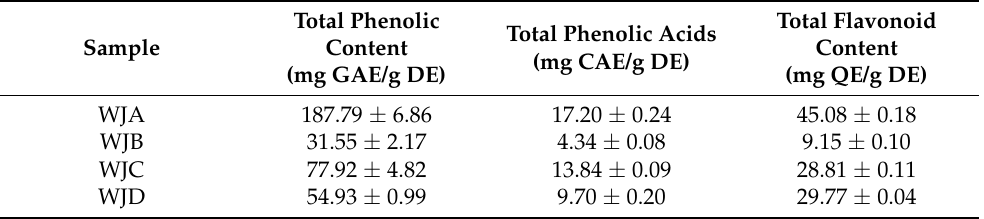
Table 1. The total content of phenolic (TPC), flavonoid (TFC), and phenolic acids (TPAC) in the flowers (WJA), roots (WJB), and leaves (annual—WJC and biennial—WJD) of E. japonicum . DE—dry extract; GAE—Gallic Acid Equivalent; CAE—Caffeic Acid Equivalent; QE—Quercetin Equivalent. Values were presented as the mean ± standard deviation ( n =